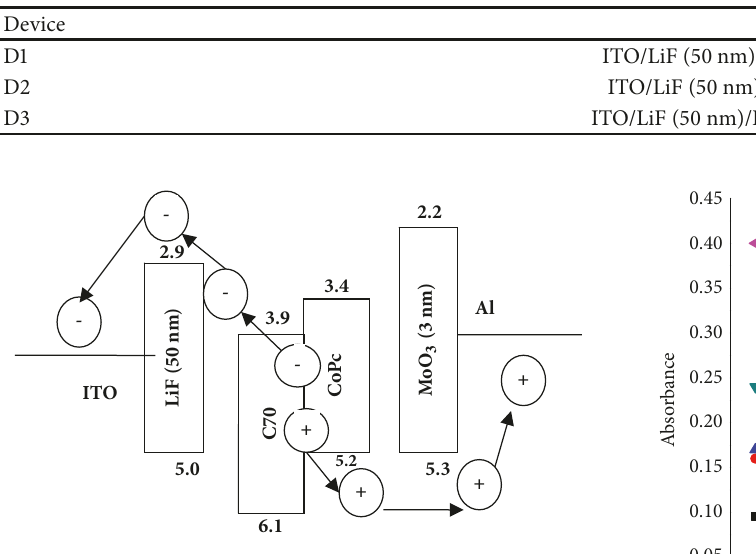
Table 2: C-V characteristics of three devices D1, D2, and D3.